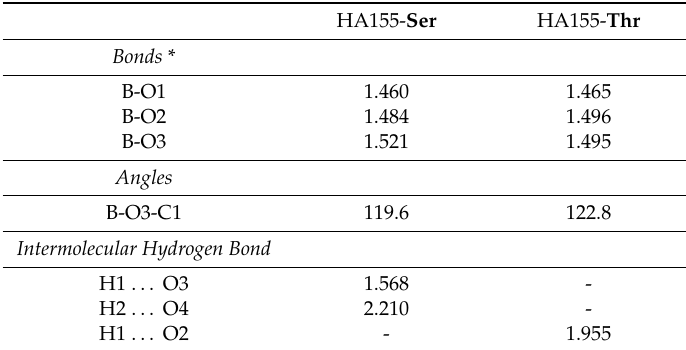
Figure 5. Optimized geometries of the bonded structures of the inhibitor HA155 with serine ( top ) and threonine ( bottom ) at the B3LYP/6-31+G(d,p) level of theory, with their respective intramolecular HBs as dashed lines. Figure 6. Highest occupied molecular orbitals (HOMOs) of the HA155- Ser ( top ) and HA155- Thr ( bottom ) at the B3LYP/6-31+G(d,p) level of theory.